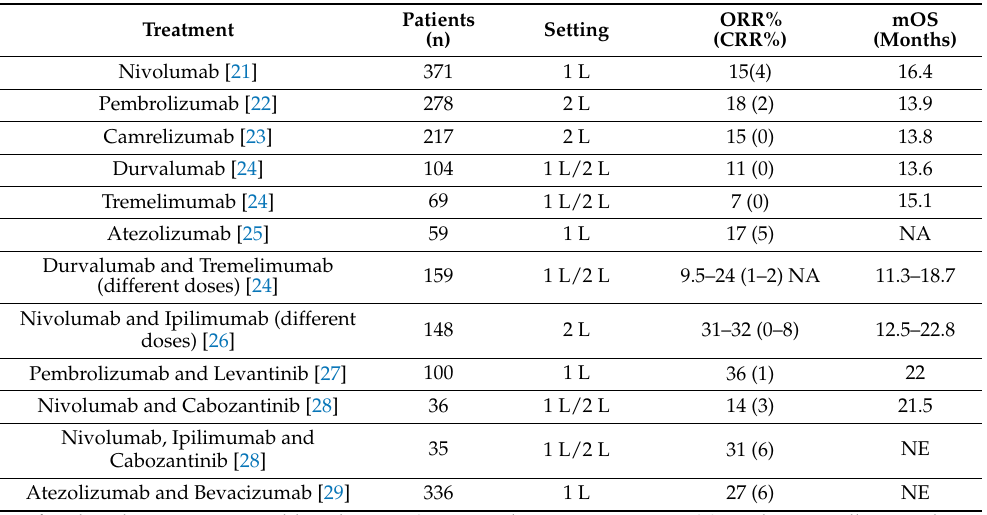
Table 1. Immunotherapy with ICI in HCC (clinical trial with reported results). Treatment Patients (n)